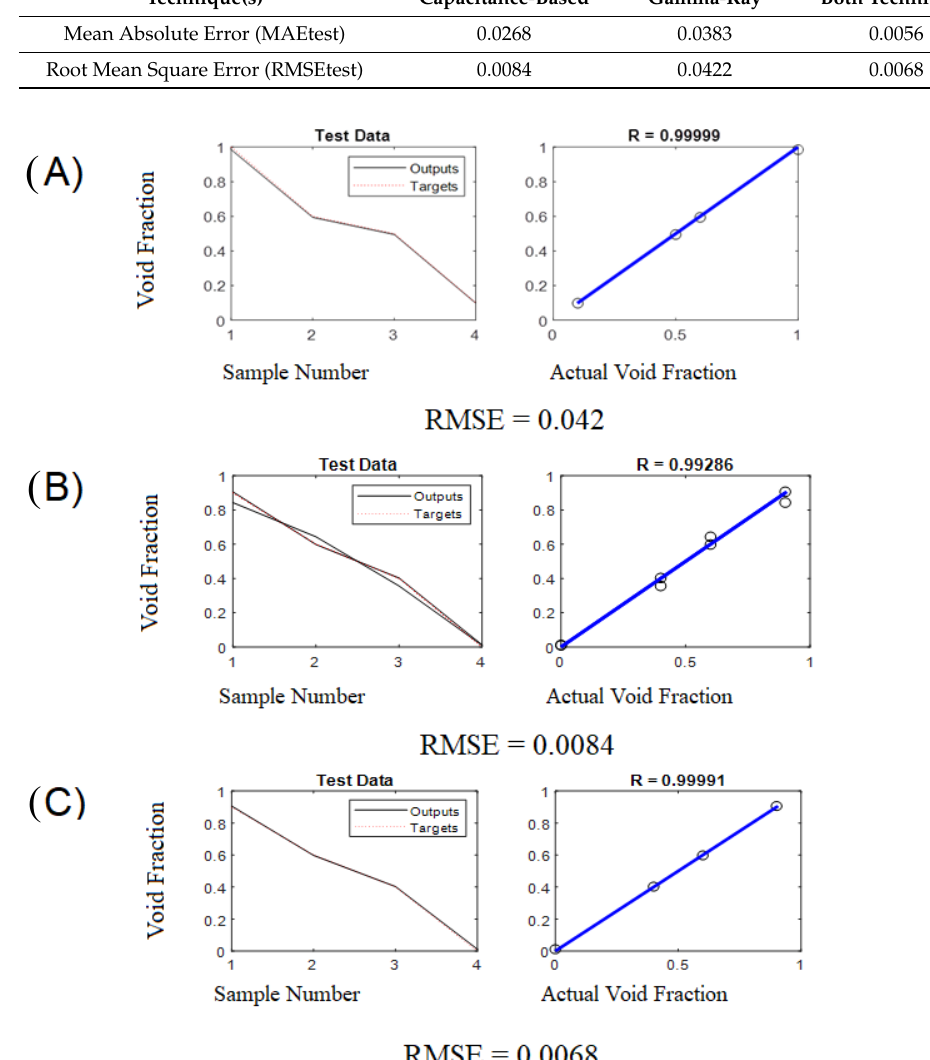
Figure 5. Neural network performance for ( A ) gamma-ray, ( B ) capacitance, ( C ) capacitance and gamma-ray in annular flow regime. Table 2. ANN relative-error criterion of three techniques.